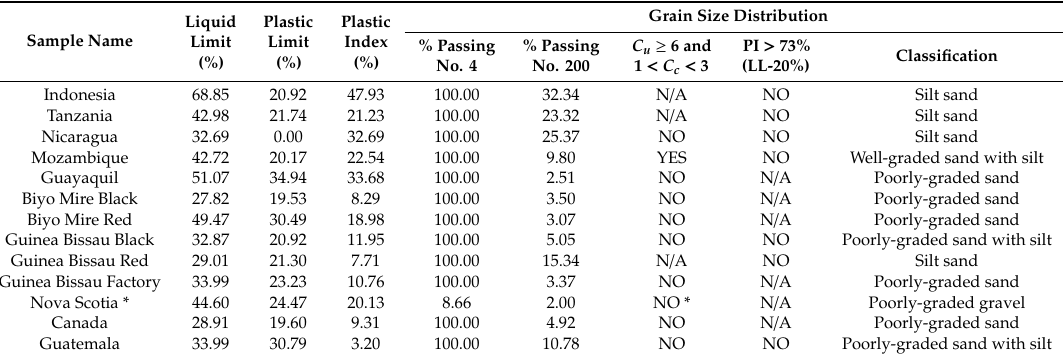
Table 2. Liquid limit, plastic limit, plastic index, and classification of clayey material